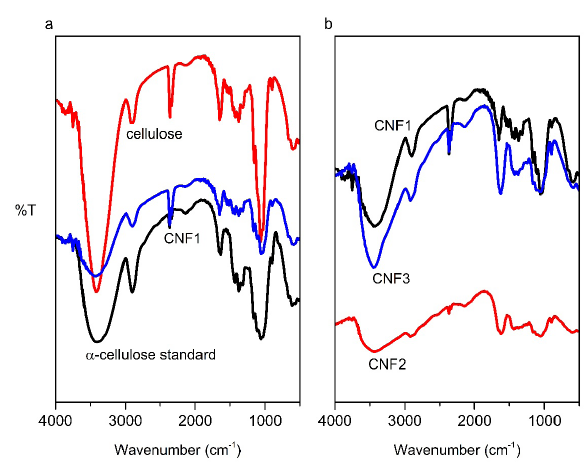
Figure 1: FT-IR spectra of α-cellulose and all CNF